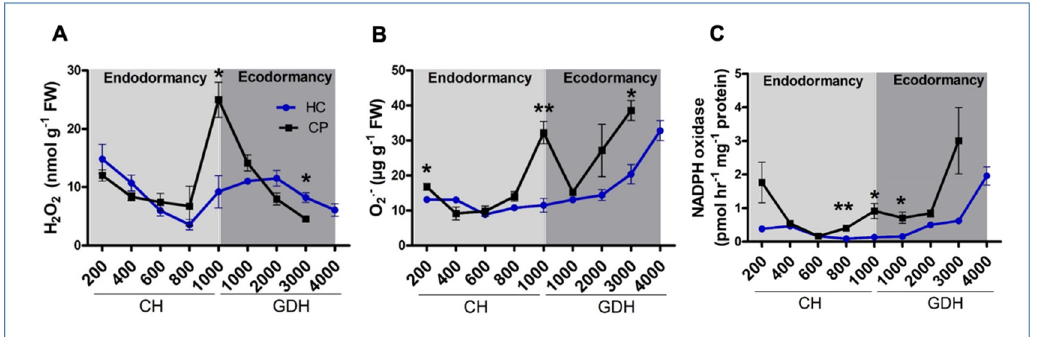
Figure 3. Profiles of hydrogen peroxide, H 2 O 2 ( A ), superoxide radical, O 2• − ( B ) contents, and NADPH oxidase activity ( C ) in two apple cultivars ‘Honeycrisp’ and ‘Cripps Pink’ from the time of endodormancy induction to the bud break stage. Each point represents mean ± SEM of three biological replicates; p -value indicates comparison between ‘Honeycrisp’ and ‘Cripps Pink’ (* p < 0.05, ** p < 0.01) using students t - test.